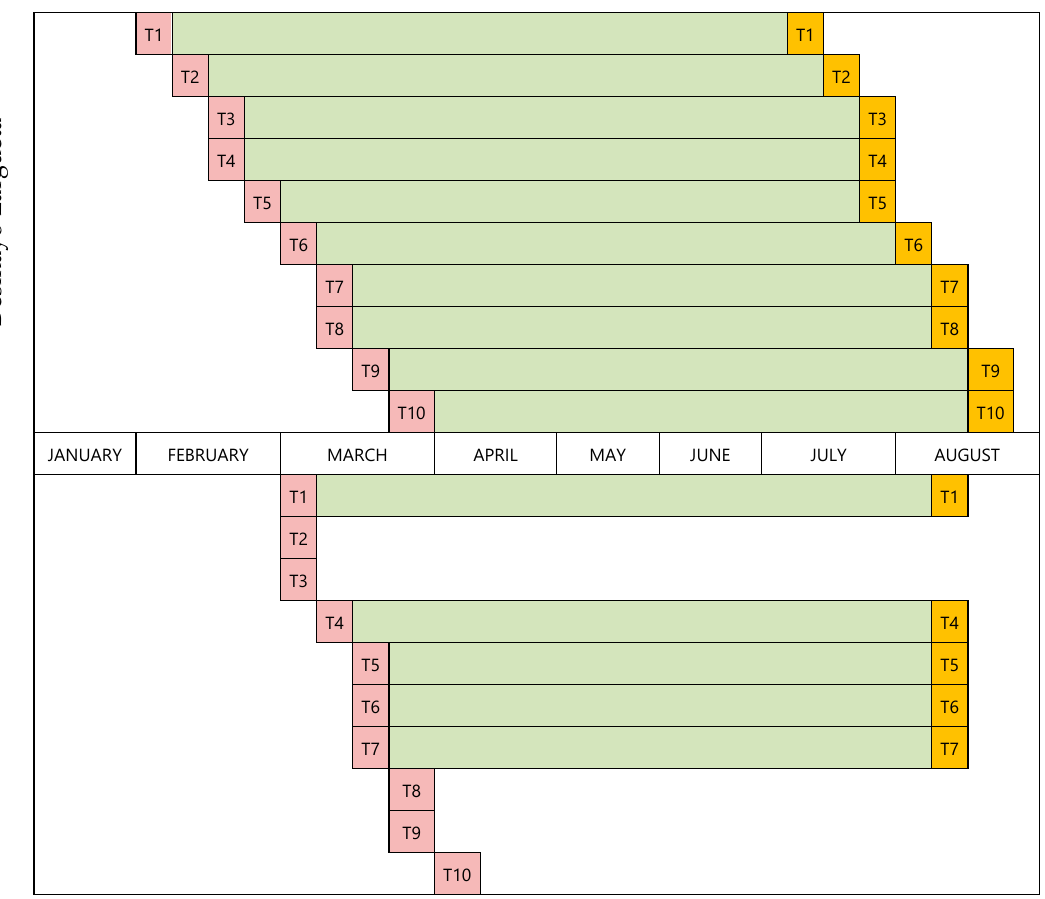
Figure 7. Flowering time (pink boxes) and ripening time (orange boxes) of almond treatments (T1–T10) in Season 3. The fruit development period is represented by a green bar.